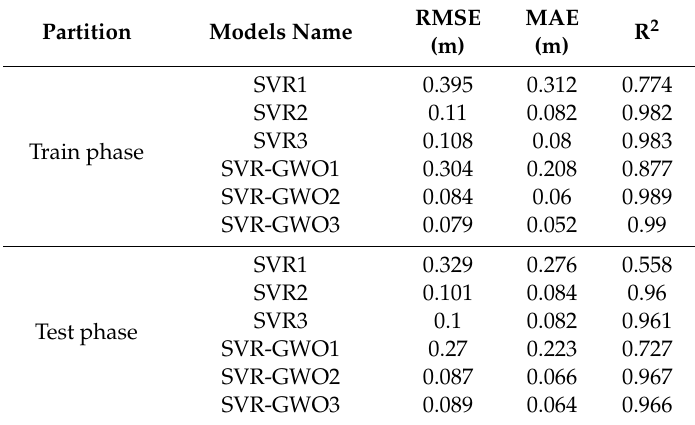
Table 4. Performance evaluation of the SVR and SVRGWO models by di ff erent pre-processing methods in train and test